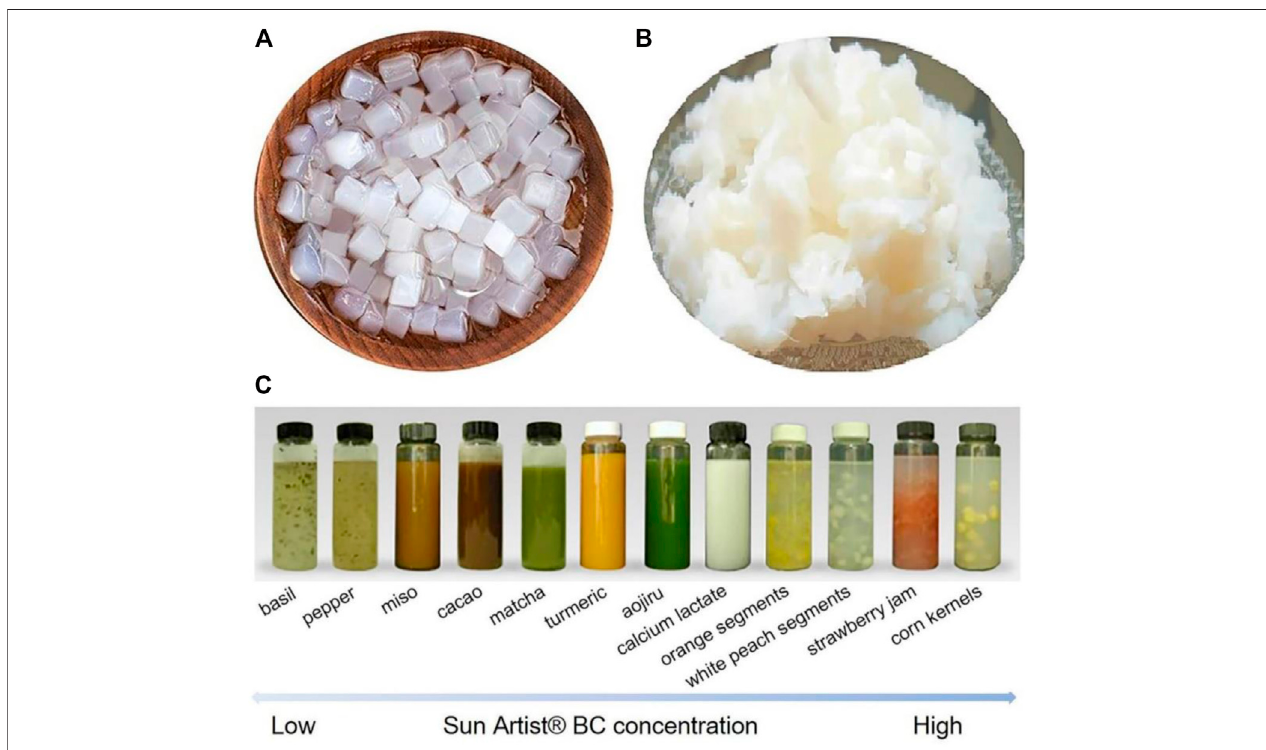
FIGURE 6 | Utilization of BNC granules as food additives; (A) a static fermentation and cutting procedure produces the cube-shaped BNC, and (B) a two-step compression approach produces the compressed BNC. (C) Sun Artist ® BNC is a high-stability suspension agent for a variety of solid food products. Reprinted with permission from Zhong (2020) under Creative Commons Attribution License (CC